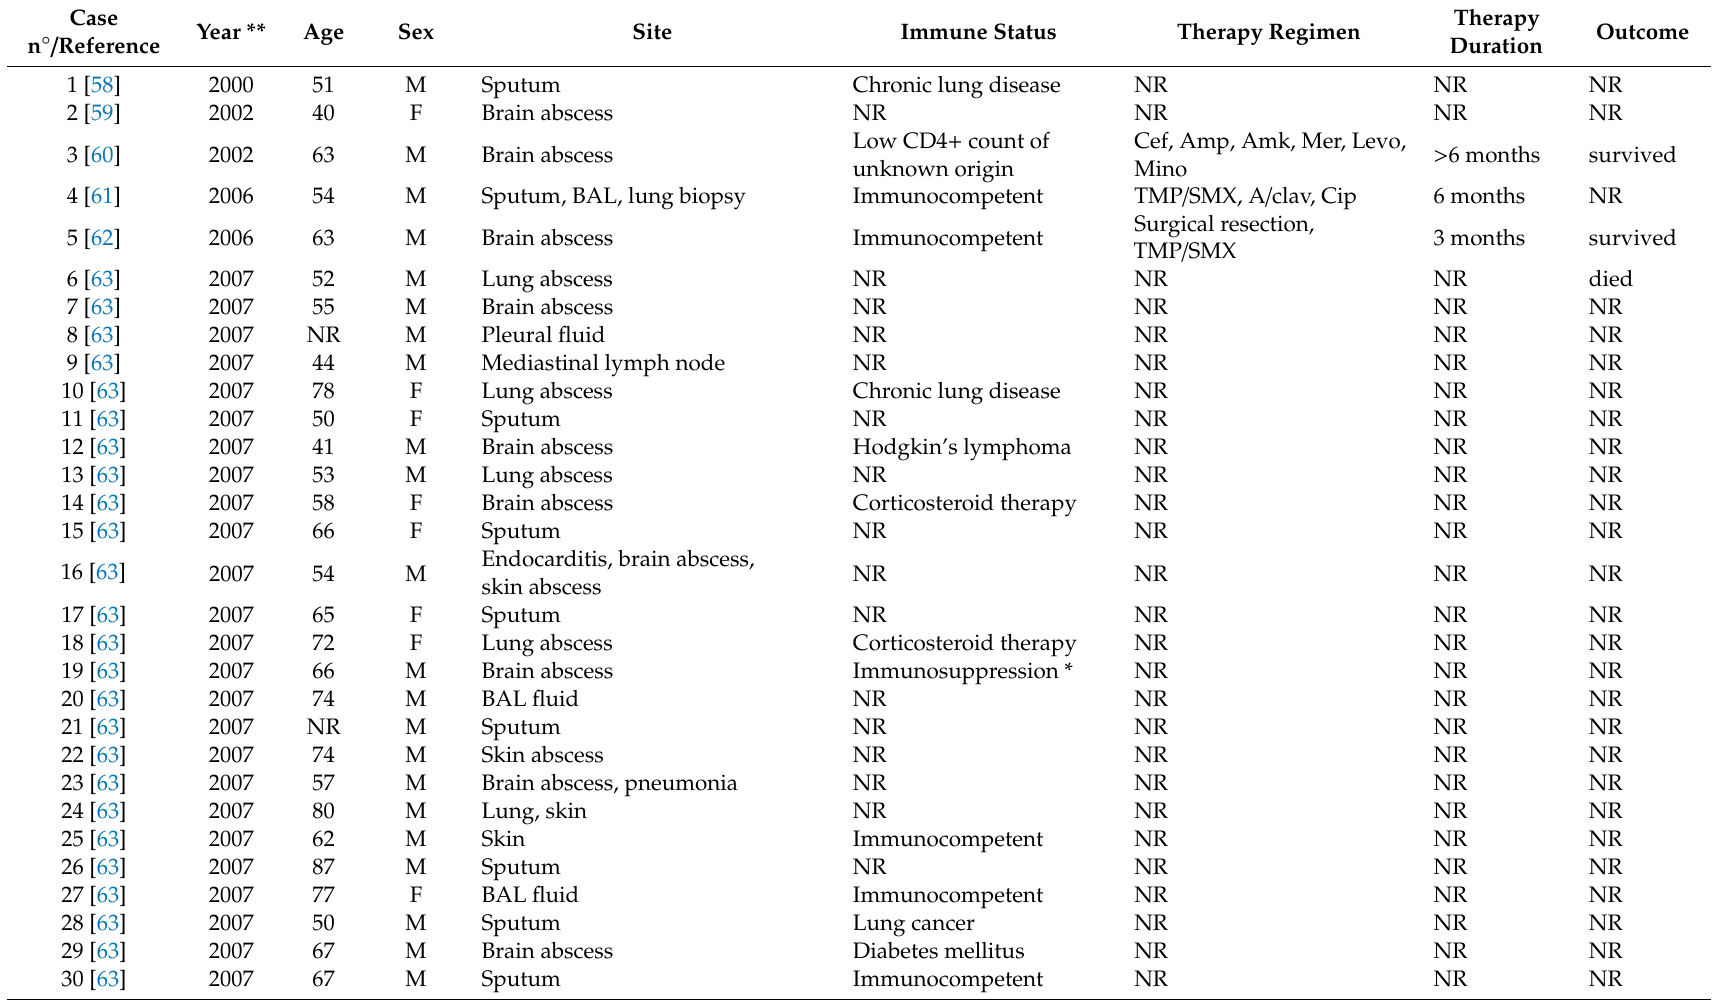
Table 1. Previously published cases of Nocardia paucivorans